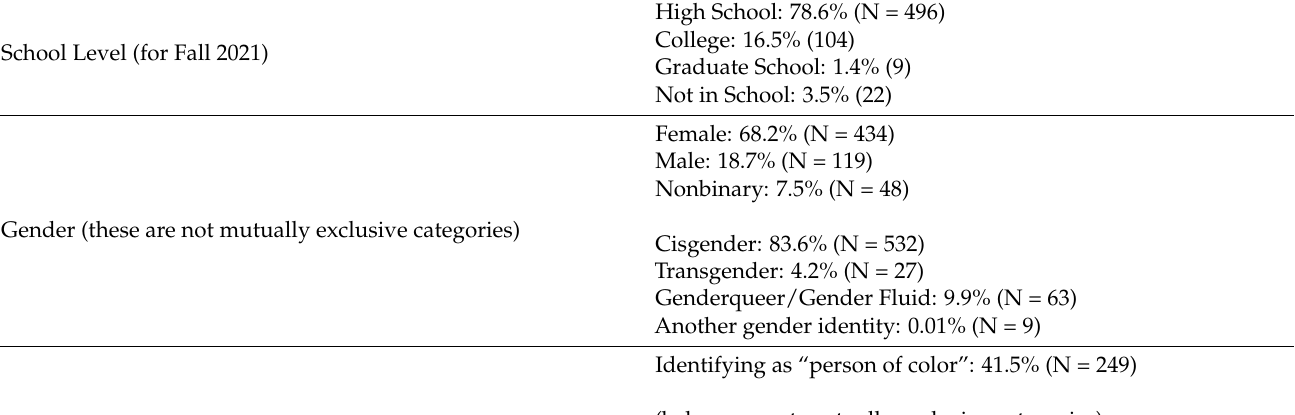
Table 1. Characteristics of Questionnaire Sample (N =